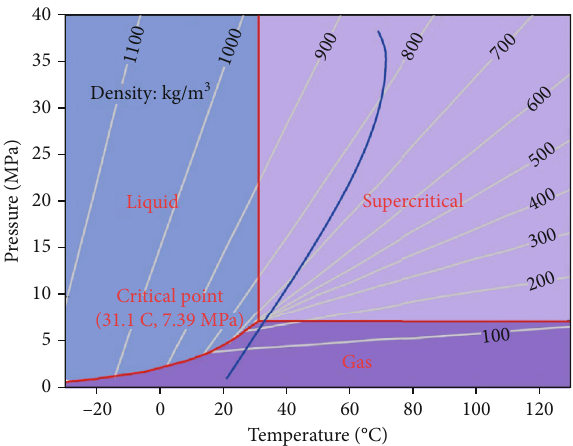
Figure 1: Phase diagram of carbon dioxide. The blue curve represents a typical temperature-pressure distribution in the fl ow. As seen, the phase and thermophysical wellbore as CO 2 properties of CO can vary signi fi 2